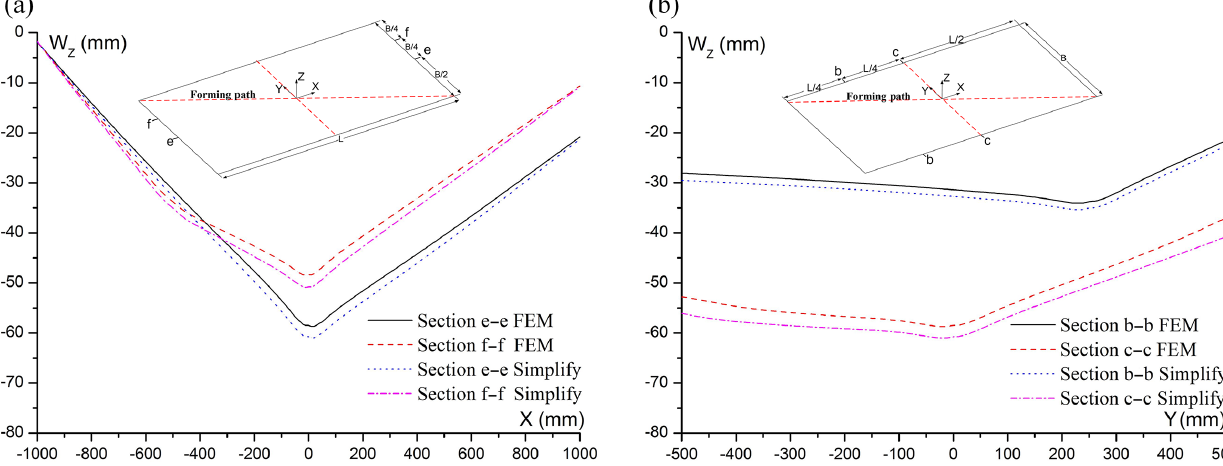
Figure 13. Comparison of deformation between elastoplastic FEM and simplified deformation simulation method (two lines). (a) Results from longitudinal sections. (b) Results from lateral